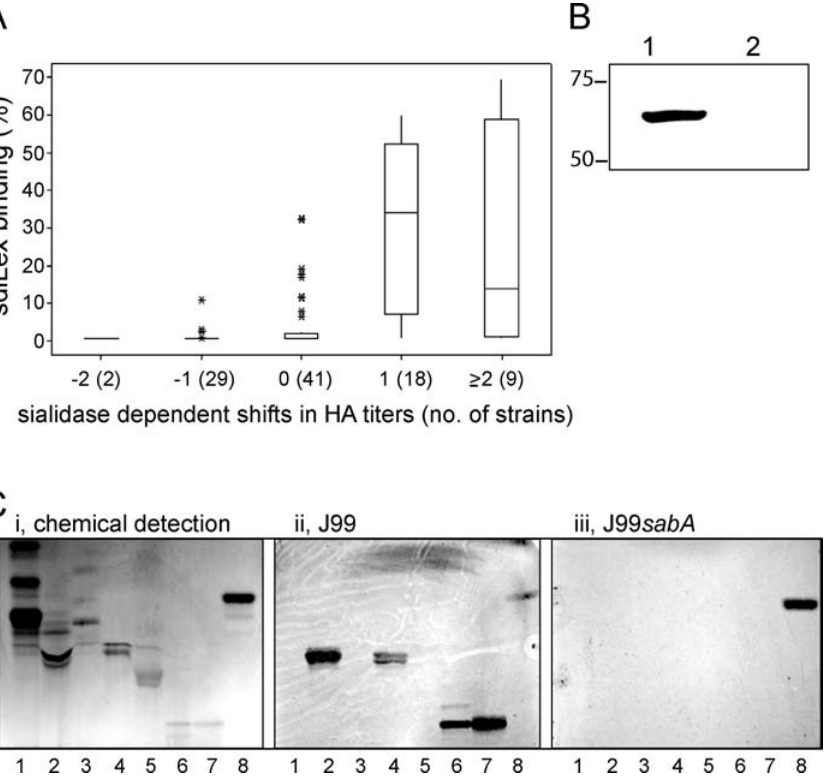
Figure 2. Characterization of Binding Properties of the SabA Adhesin, and Its siaHA Properties (A) A panel of 99 Swedish clinical H. pylori isolates was tested for sia-HA properties and for binding to 125 I-sdiLex conjugate. The numbers on the x axis indicate the shifts in HA titers after sialidase treatment: positive values indicate lowered sia-HA titers (i.e., sia-HA, whereas negative values indicate increased HA titers (i.e., sialic acid–independent HA). No change in HA titer is indicated by 0. The y axis gives the percentage of bound sLex-conjugate. (B) SabA was affinity-adsorbed to erythrocytes from a cell-surface protein extract of strain J99. Immunostaining using SabA antibodies confirmed the presence of SabA adsorbed onto the erythrocyte surfaces as a result of binding to sialylated glycans (lane 1), whereas SabA was completely absent when erythrocytes had been depleted of sialic acid by sialidase treatment prior to the test (lane 2). Molecular weight markers (in kDa) are indicated. (C) Binding of H. pylori strains J99 and J99 sabA to human erythrocyte glycosphingolipids. (i) Chemical detection by anisaldehyde. (ii–iii) Autoradiograms obtained by binding of 35 S-labeled H. pylori strain J99 and the J99 sabA mutant, respectively, to separated glycosphingolipids. The lanes contain non- acid glycosphingolipids of human erythrocytes, 40 l g (lane 1); gangliosides of human erythrocytes, 40 l g (lane 2); GM3 ganglioside (NeuAc a 2– 3Gal b 4Glc b 1Cer), 4 l g (lane 3); NeuAc a 2–3-neolactotetraocylceramide (NeuAc a 2–3Gal b 4GlcNAc b 3Gal b 4Glc b 1Cer), 4 l g (lane 4); NeuAc a 2–6-neolactotetraocylceramide (NeuAc a 2–6Gal b 4GlcNAc b 3Gal b 4Glc b 1Cer), 4 l g (lane 5); G-10 ganglioside (NeuAc a 2–3Gal b 4GlcNAc b 6 (NeuAc a 2–3Gal b 4GlcNAc b 3)Gal b 4GlcNAc b